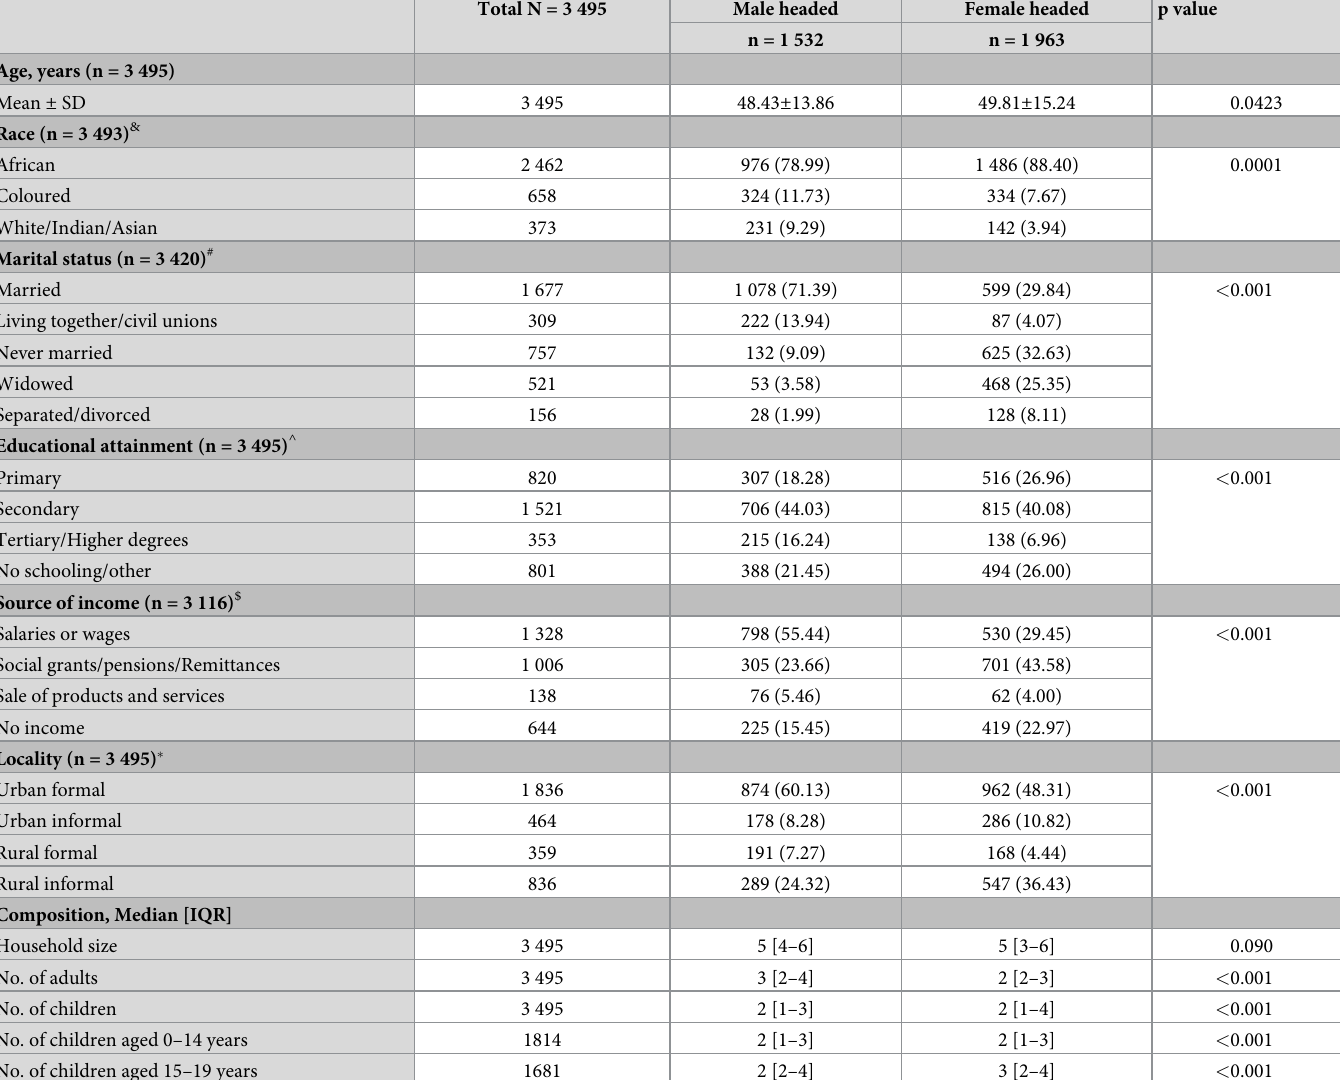
Table 3. Sociodemographic characteristics of male and female-headed households with